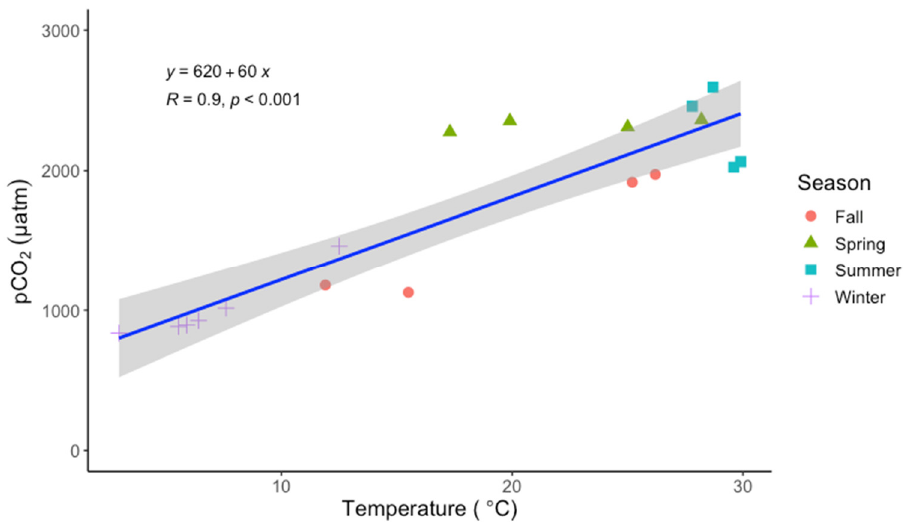
Figure 4. Positive correlation between p CO 2 and water temperature in the Mississippi River across the study period.